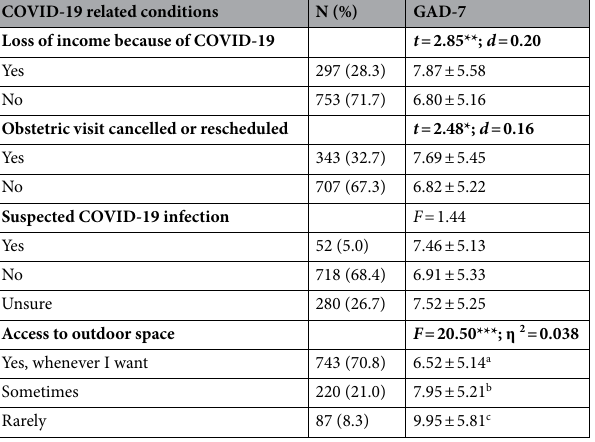
Table 2. Sample characteristics and mean differences in GAD-7 scale score based on COVID-19 related conditions (N = 1050). * p < . 05; ** p < . 01; *** p < . 001. Estimates of effect sizes: d—Cohen’s d; η 2 —eta squared. Means with different superscripts are significantly different at p < 0.05 in a post hoc Scheffé test.